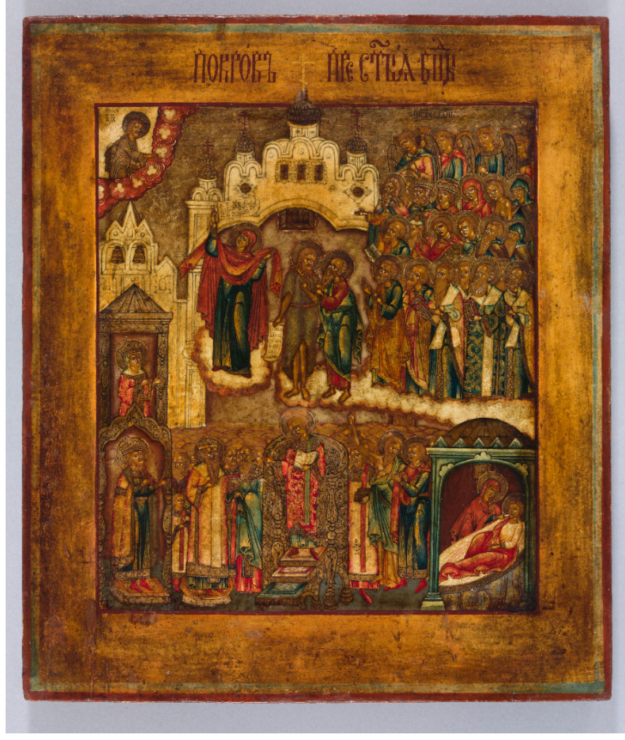
Figure 10. Pokrov of Mother of God, Russia, Volga region, workshop of the Old Believers, 18th c., tempera on wood, 31.5 × 27 cm, National Museum in Warsaw, photo: Krzysztof